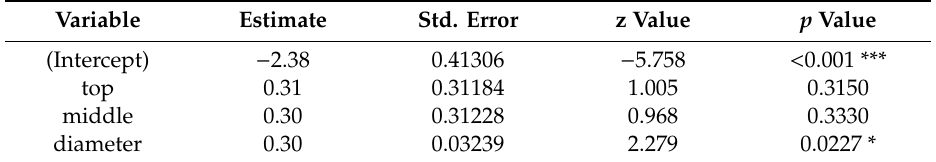
Table 4. Results of a GLM model describing the relationship between the number of entry holes of Ips cembrae per dm 2 and the following variables in experiment 1: position on the log (top, middle, and bottom = included in Intercept); diameter. Corrected Akaike’s Information Criterion (AIC) = 210.09. Number of Fisher Scoring iterations was 5. ***, and * indicate significance at p < 0.001, and 0.05, respectively.